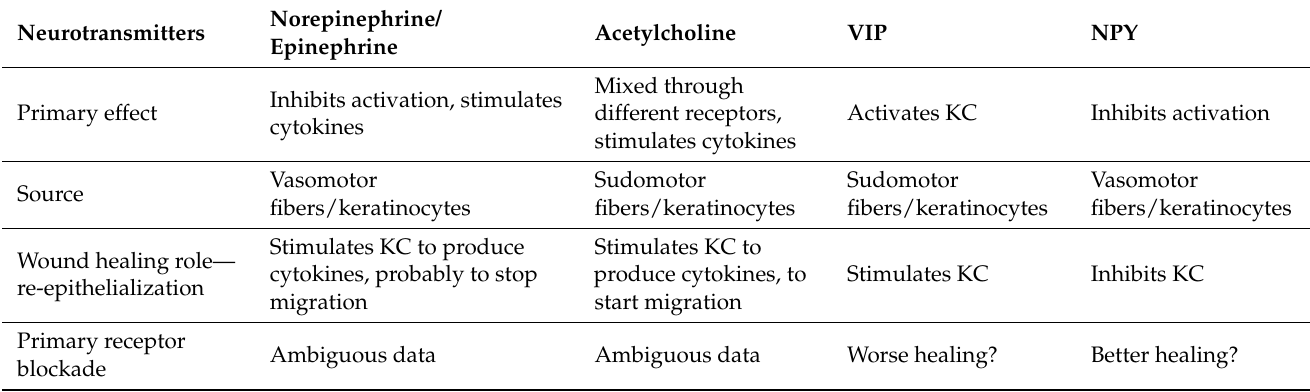
Table 2. Overview of sympathetic neurotransmitter interactions with